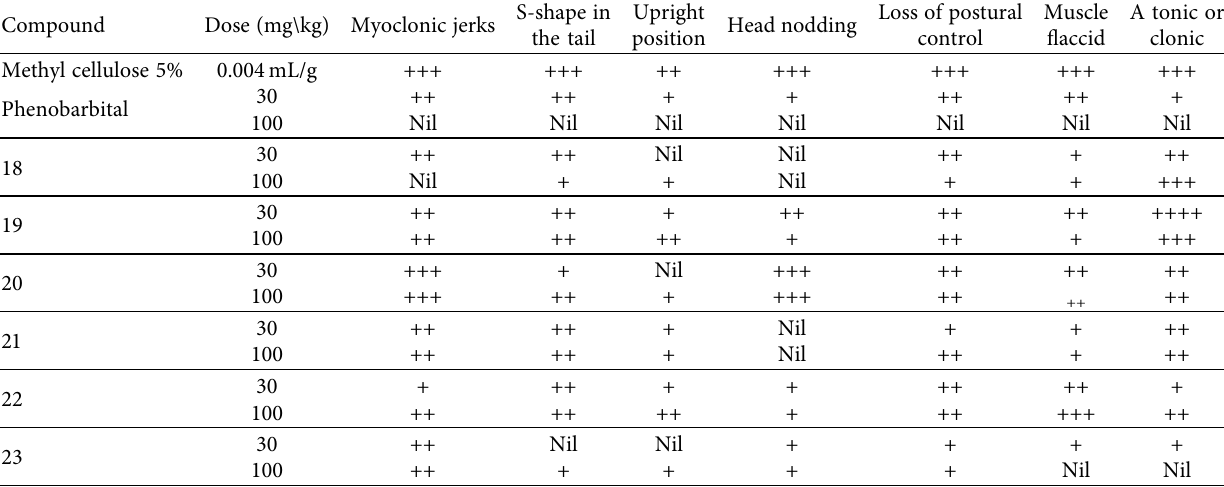
Table 3: Effect of synthesized compounds on neurological signs ∗ of PTZ-induced seizure 1 hour after induction. Compound